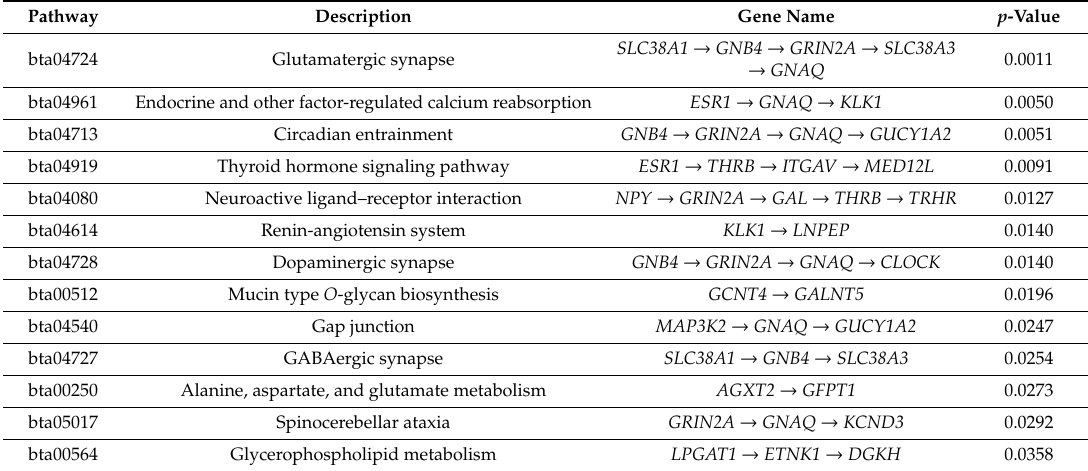
Table 2. Information on di ff erentially expressed genes’ enrichment